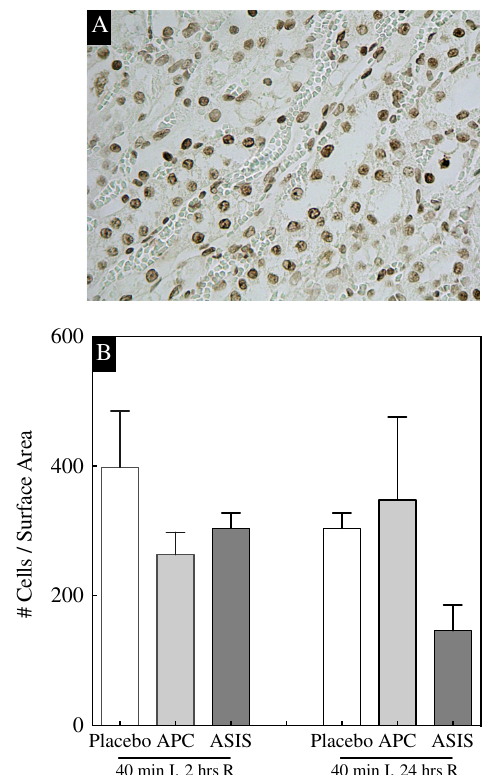
Figure 6. Panel A: representative picture of a TUNEL stained par- af fi n section. Apoptotic cells are shown in brown, the cell nuclei are depicted in green; 40 (cid:1) magni fi cation. Panel B: slides were scored for the number of positive cells within 3 fi elds of the infarcted area using a 40 (cid:1) magni fi cation. No difference in the number of apoptotic cells was observed upon ASIS or APC administration during both the ischemic and the reperfusion phase within the corticomedullary junction ( n =